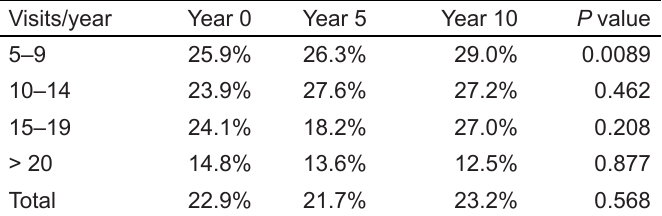
Table 2. Admission rates for frequent emergency department user groups in years 0, 5, &